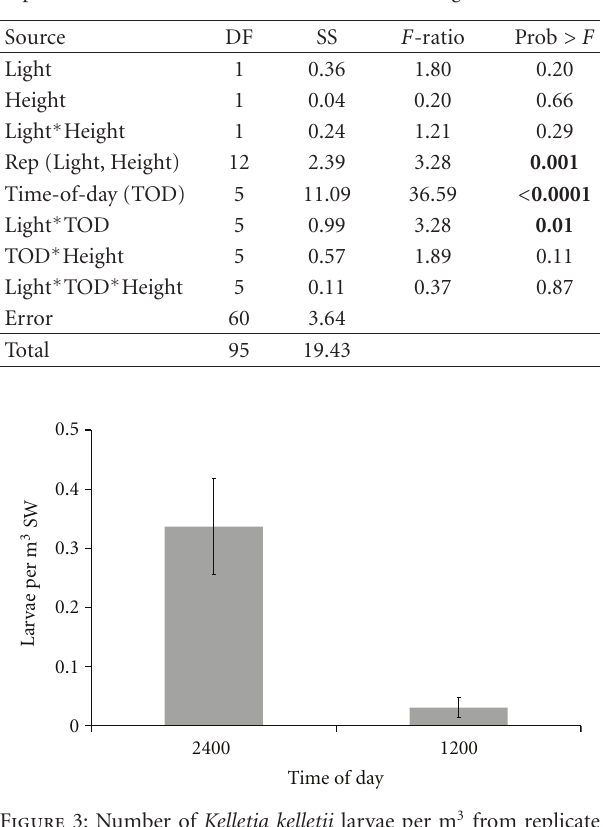
Figure 3: Number of Kelletia kelletii larvae per m 3 from replicate ( n = 5) surface plankton tows conducted at 2400 and 1200 h o ff Palos Verdes, CA, in June 2007. Error bars represent ±